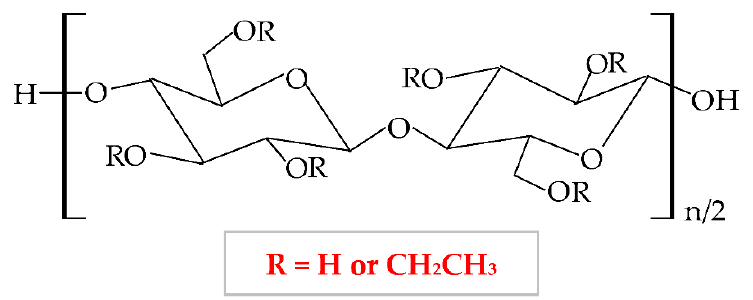
Figure 11. Chemical structure of ethylcellulose (EC).